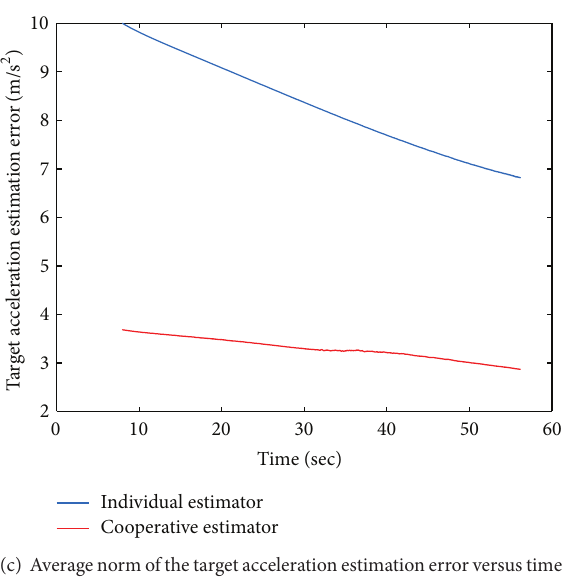
(a) Average norm of the range-to-go estimation error versus time in terminal phase for individual and collaborative estimators